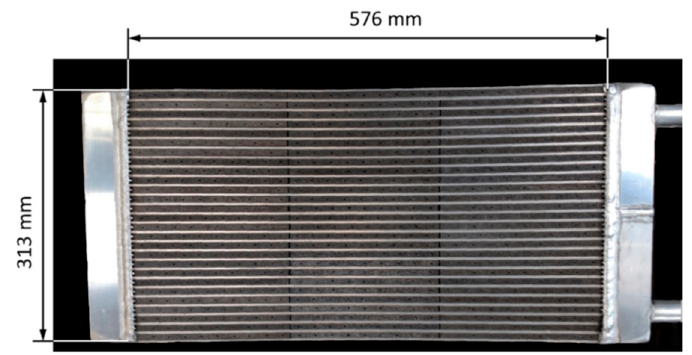
Figure 10. Fiber heat exchanger developed and tested by Wittstadt et al. (2017)